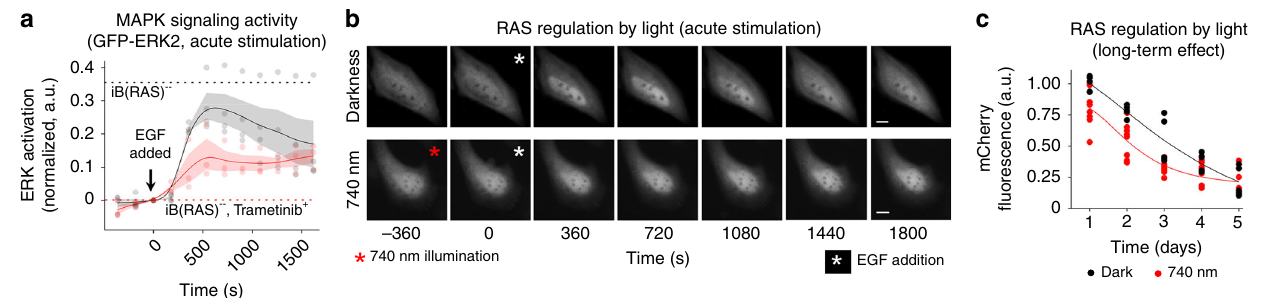
Fig. 8 Endogenous RAS regulation using light-controlled intrabody. a Light regulation of MAPK pathway in cells co-expressing optogenetically controlled iB(RAS) and GFP-ERK2. Signal in cells preilluminated with 740 nm light for 20 min before t = 0 s is shown in red, signal in cells kept in darkness is in gray. Filled areas represent SEM, n ≥ 3. Dashed lines show ERK activation level at t = 540 s, in cells expressing only GFP-ERK2 reporter, in presence of 500 nM trametinib (mean = 0.001, shown in red; SEM = 0.023) or without inhibitor (mean = 0.355, shown in black; SEM = 0.052). Source data are provided as a Source Data fi le. b EGF stimulation of cells expressing iB(RAS) and GFP-ERK2, in darkness and under 740 nm illumination. Epi fl uorescence microscopy; scale bar, 10 µ m. c Cells expressing system for RAS light-regulation show lower survival rate under 740 nm (red line) as compared with those kept in darkness (black). Source data are provided as a Source Data fi